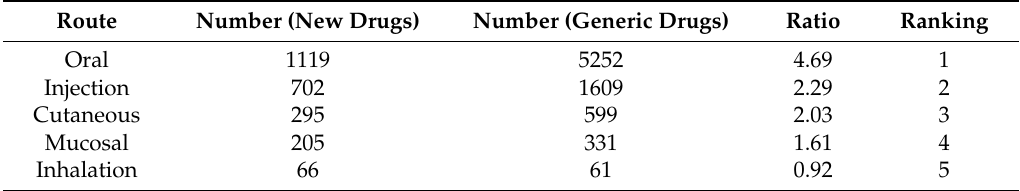
Table 2. The ratio of generic drug quantity to new drug quantity.